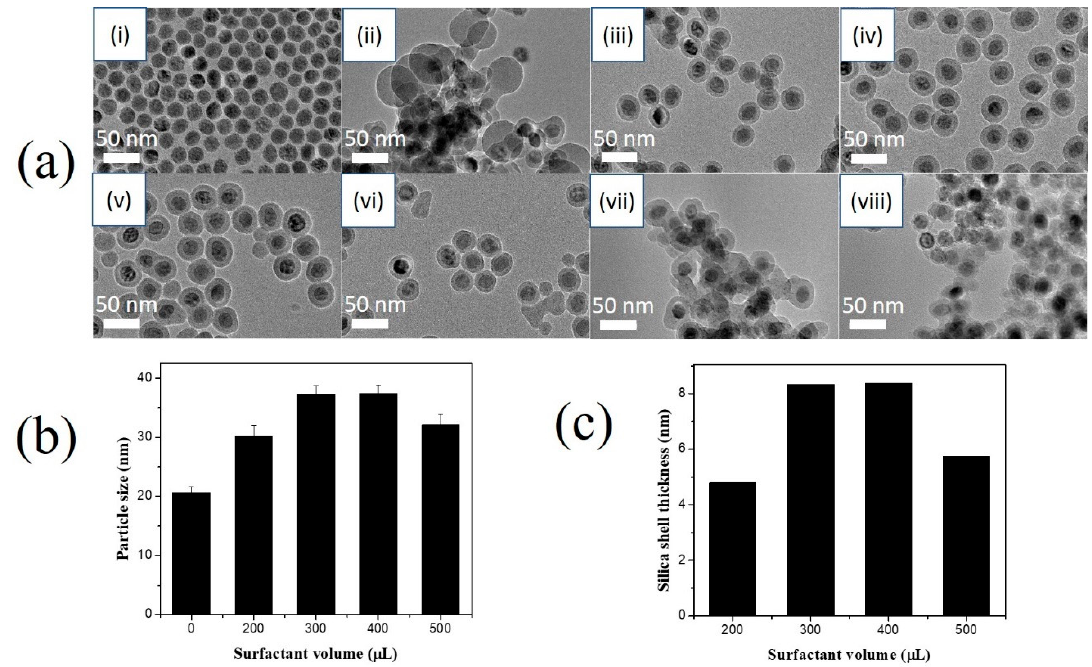
Figure 2. E ff ects of reverse microemulsion conditions on the silica coating of the magnetic nanoparticles. ( a ) Transmission electron microscope (TEM) images, ( b ) particle size and ( c ) silica shell thickness of MNP@SiO 2 synthesized at di ff erent Igepal ® CO-520 surfactant volumes: (i) 0 µ L, (ii) 100 µ L, (iii) 200 µ L, (iv) 300 µ L, (v) 400 µ L, (vi) 500 µ L, (vii) 2500 µ L, and (viii) 5000 µ L in the presence of 5 mg of MNPs, 100 µ L of TEOS, and 100 µ L of NH 4 OH.